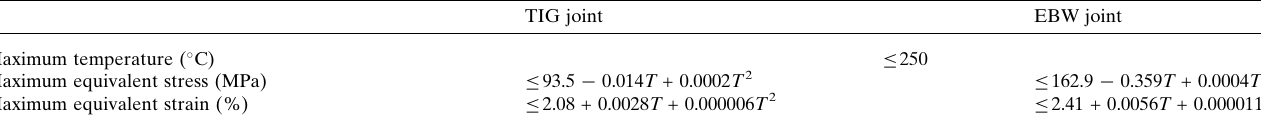
Table 9 Engineering conservative acceptance criteria of vacuum joints. Maximum temperature ( (cid:2)